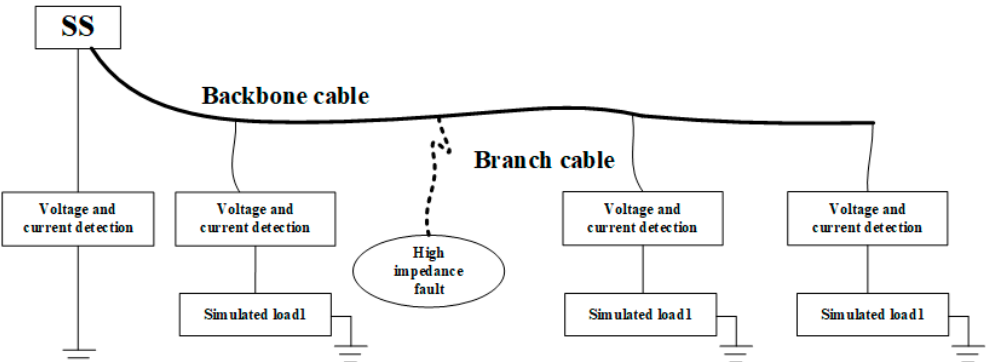
Figure 14. Schematic of fault detection experimental platform. Sensors 2020 , 20 , x FOR PEER REVIEW 15 of 22